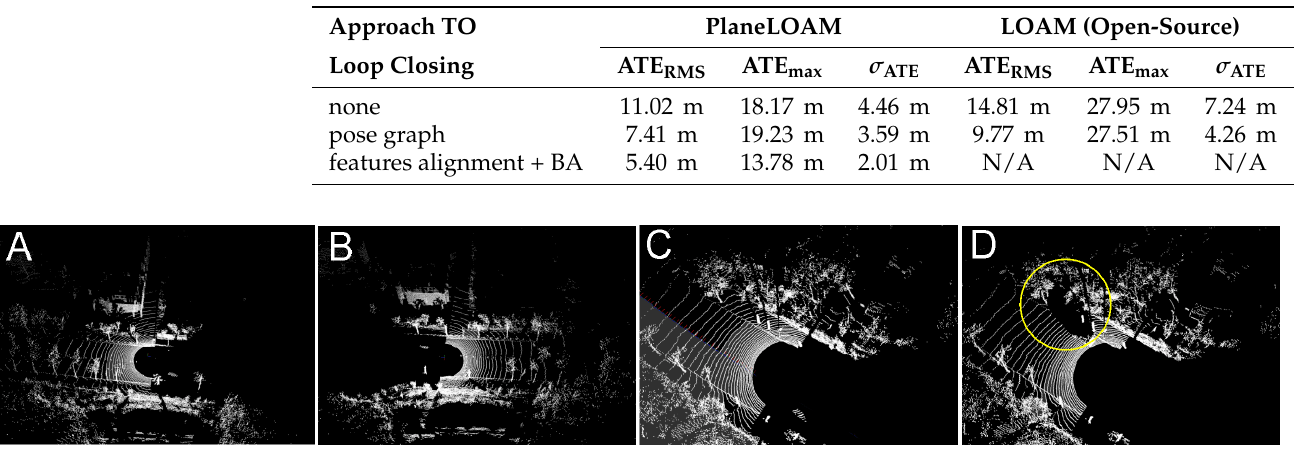
Figure 21. Visualization of example point clouds from the Mulran DCC sequence: a location visited four times while traversing a circular path with successful loop closures in spite of the reversed motion direction ( A , B ) and a location where the environment has changed due to a removed vehicle (encircled), but a loop closure was still detected ( C , D